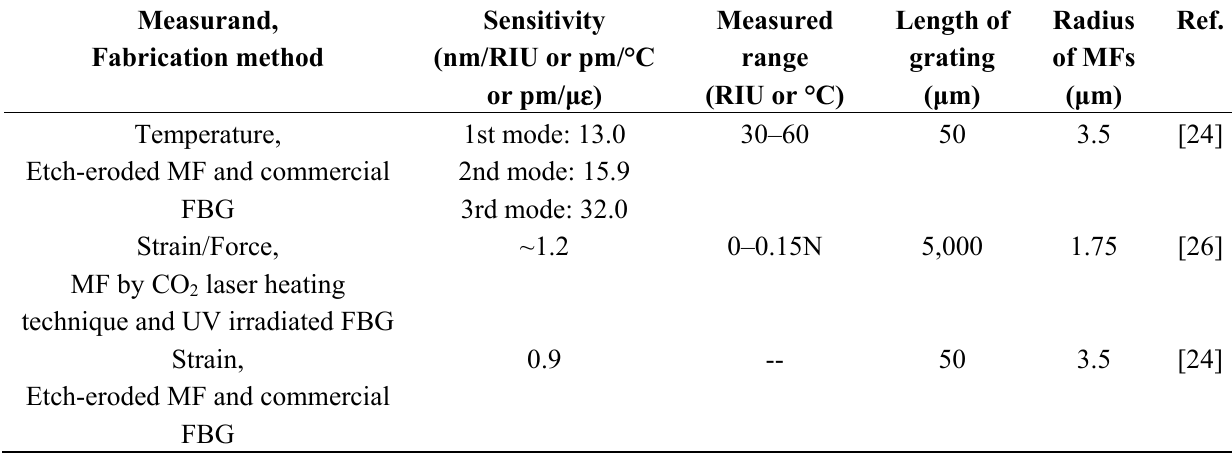
Figure 7. Dependence of wavelength shift on ambient RI for different modes in a metal-dielectric-hybrid grating. a, b, c, d denote different peaks and valleys labeled in the inset figure. Marks represent experimental results while solid lines are linear fittings. Inset: measured reflection spectra of the metal-dielectric-hybrid grating when immersed in air, acetone, and